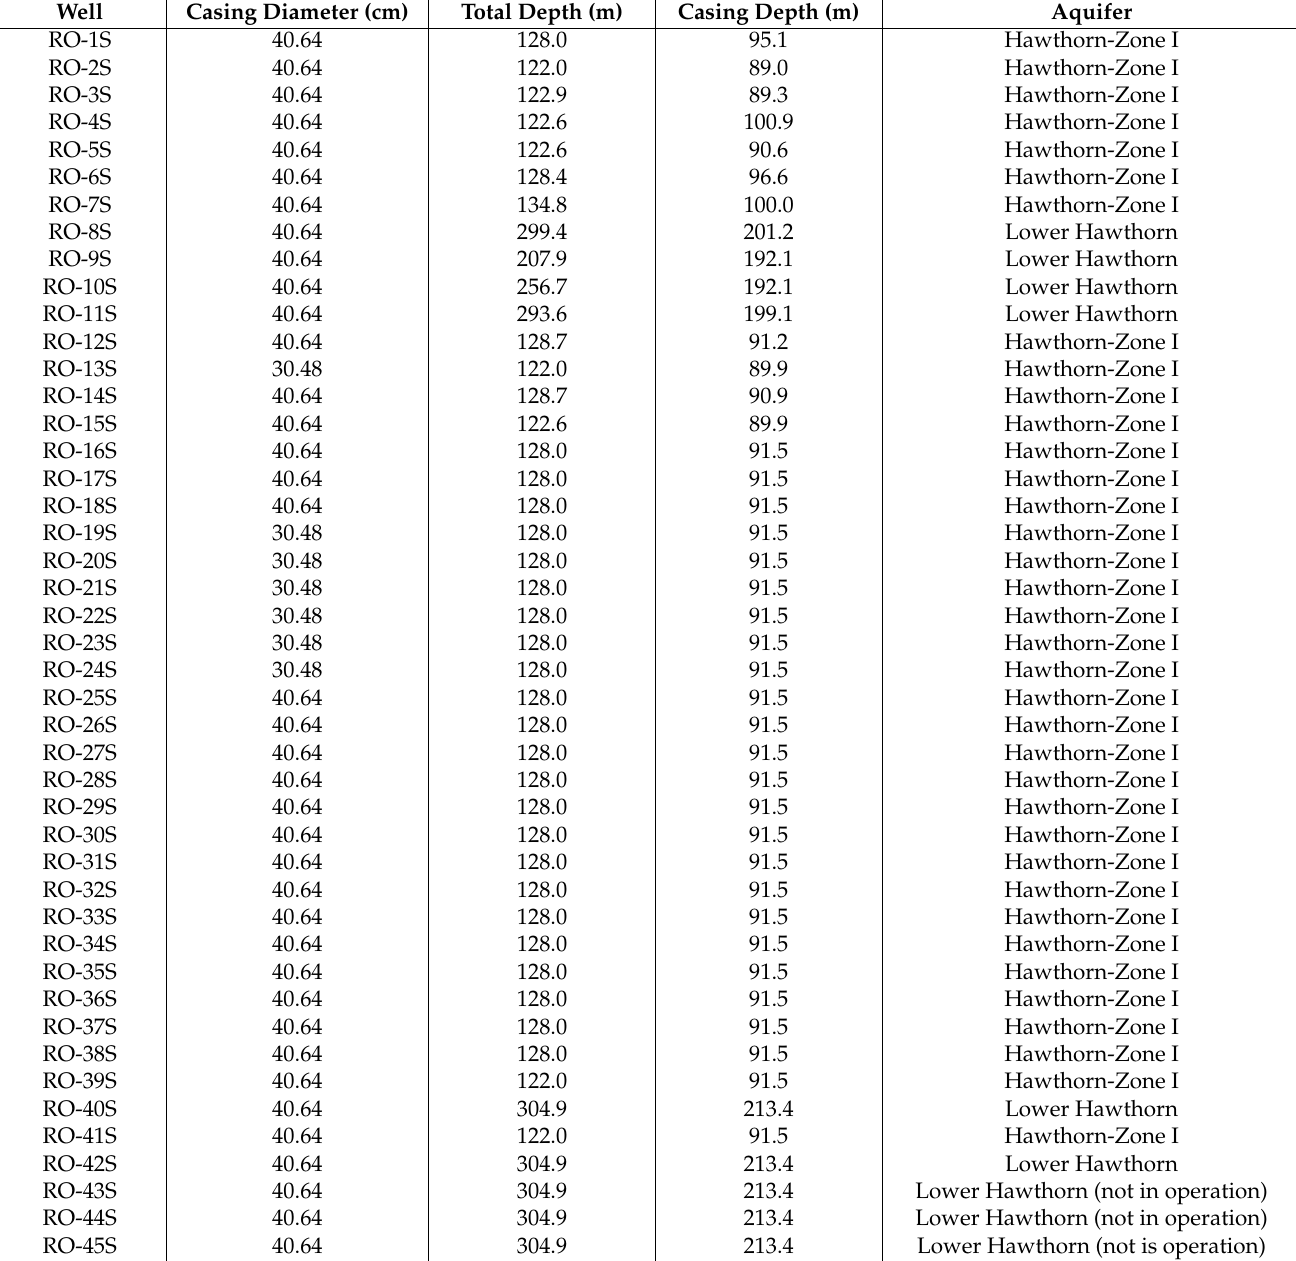
Table 1. Construction details on the production